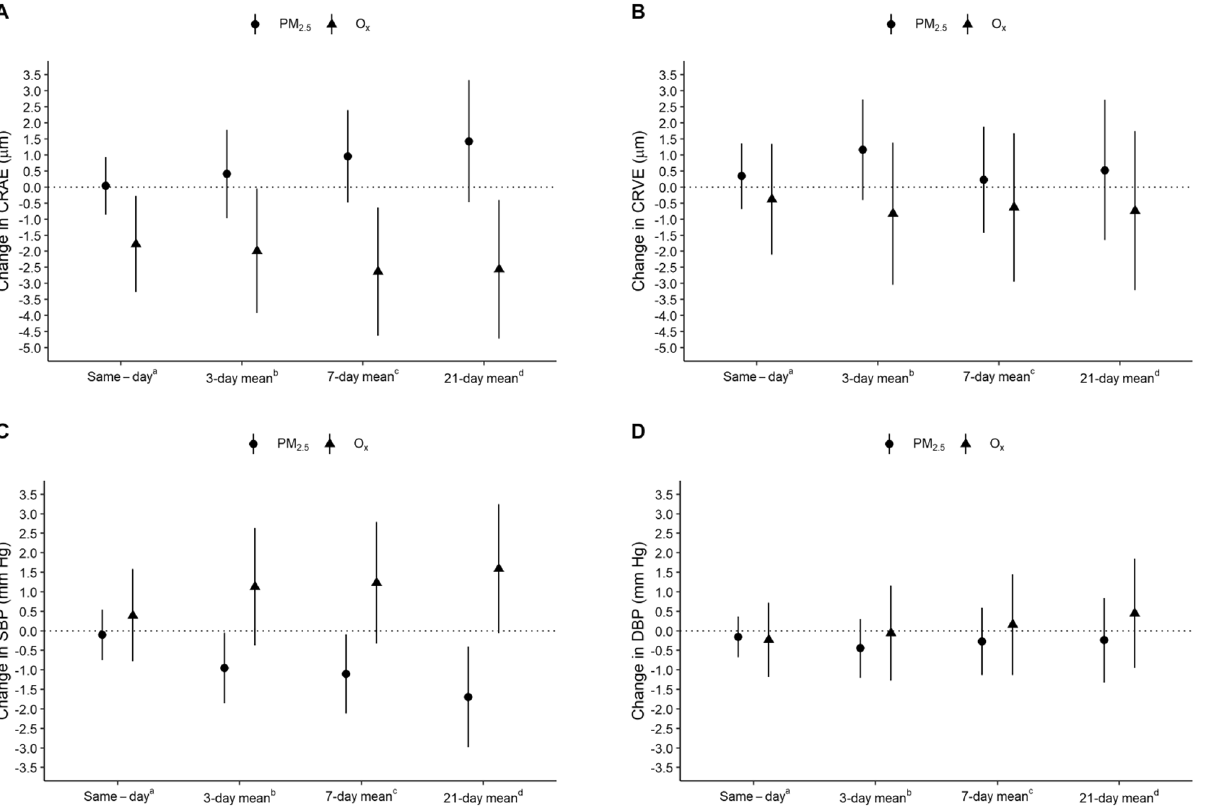
Figure 2. Estimated change (95% confidence interval) in ( A ) central retinal arteriolar diameter (CRAE, μm); ( B ) central retinal venular diameter (CRVE, μm); ( C ) systolic blood pressure (SBP, mm Hg) and; ( D ) diastolic blood pressure (DBP, mm Hg) per 5 μg/m 3 increase in PM 2.5 or 10 ppb increase in O x . Models adjusted for 7-day mean temperature and humidity, body mass index-for-age z-score on the day of the retinal image, sex, age (years), maternal education (high school or less vs. community/technical college vs. university), and time of day of outcome assessment (≤ 11:00 AM vs. > 11:00 AM). a PM 2.5 or O x on the same day as the outcome assessment. b Mean PM c Mean PM 2.5 or O x on the day of the outcome assessment and two preceding days. 2.5 or O x on the day of the outcome assessment and 6 preceding days. d Mean PM 2.5 or O x on the day of the outcome assessment and 20 preceding